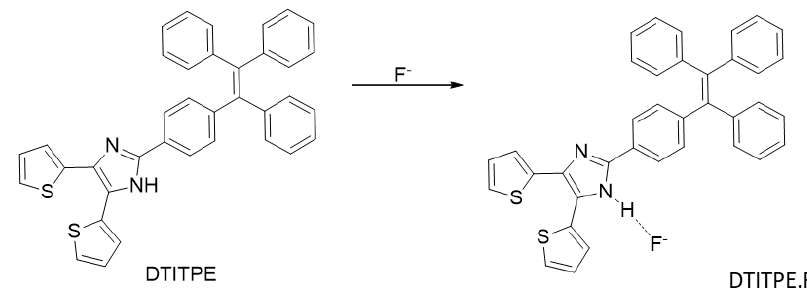
Figure 6. Optimized geometric structures of DTITPE ( left ) and DTITPE.F − ( right ), showing the elongation of the imidazole N-H bond length upon interaction with fluoride.